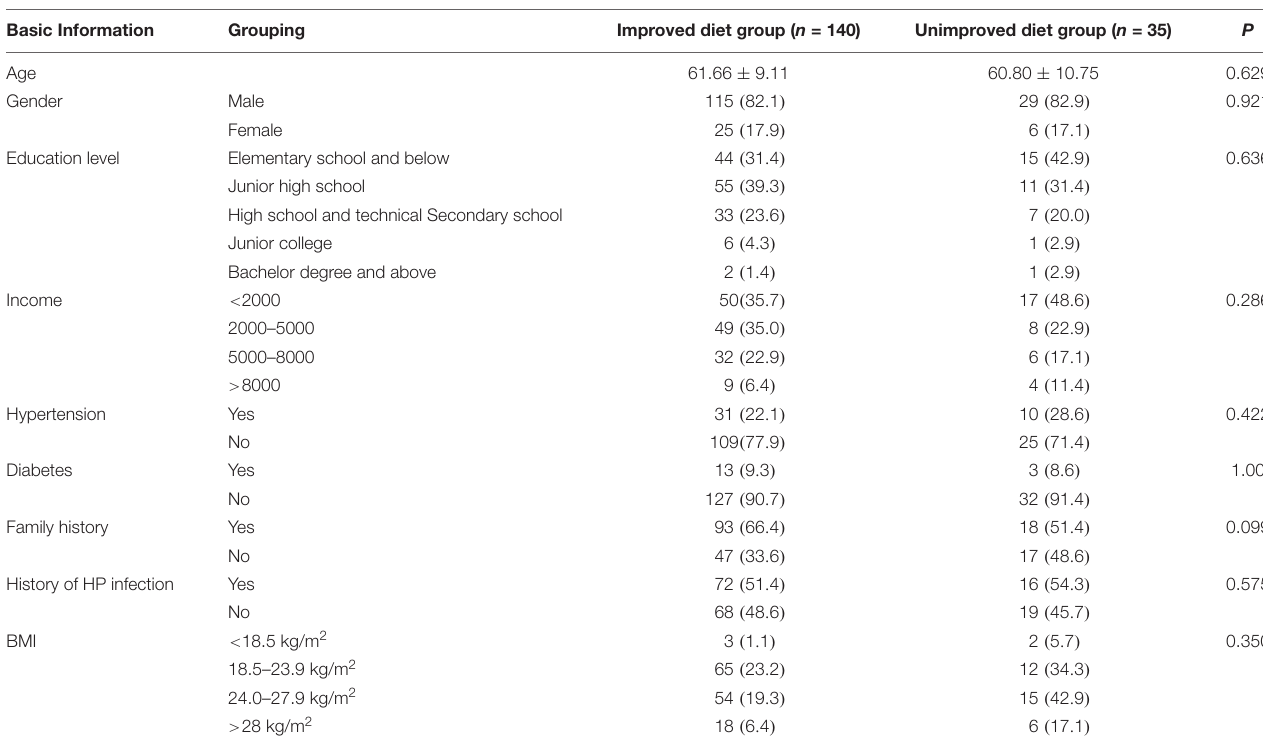
FIGURE 2 | Flow chart of the study population. TABLE 2 | Demographic data of research